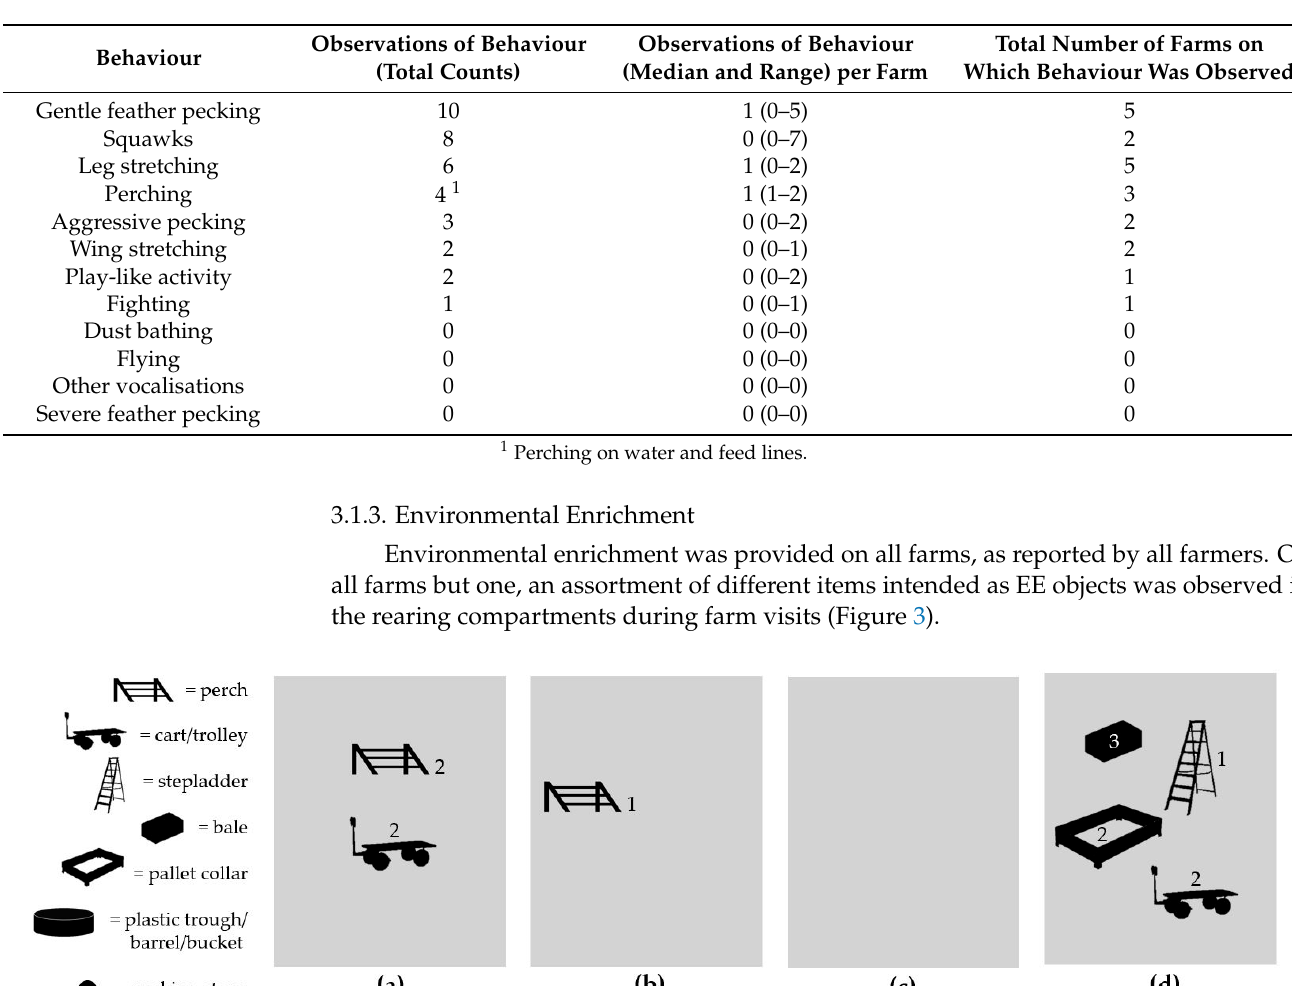
Table 3. Total number and median of event behaviours observed during behavioural observations (5 min per farm) in the rearing compartment on organic broiler farms ( n = 8), and total number of farms on which each event behaviour was observed.